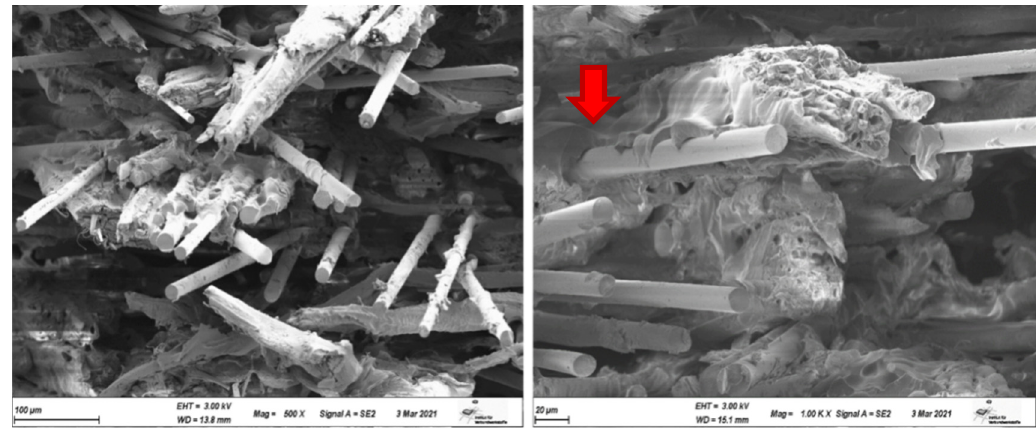
Figure 13. SEM analysis of DS/23BA/KEFL composite (wide and close